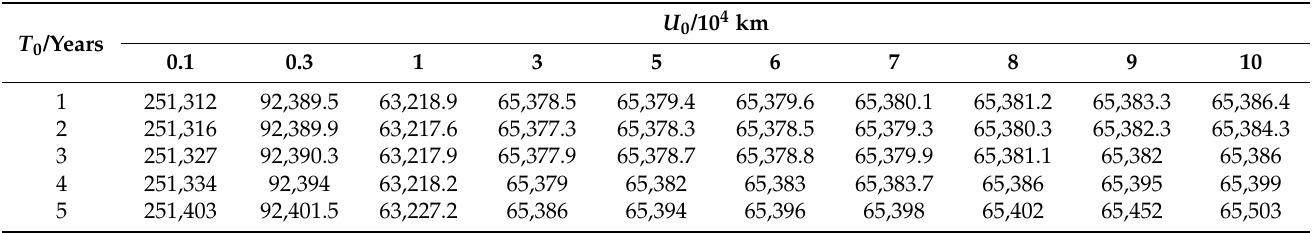
Table 4. Expected cost rate under different two-dimensional age replacement schemes.